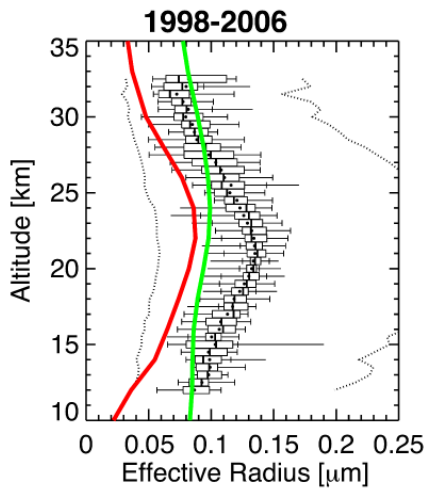
Fig. 13. Vertical profiles of the effective radius derived from OPC measurements in the stratosphere over Laramie (WY; Deshler et al., 2003a) compared to model results. The OPC data, in black, were re- binned according the vertical resolution of the model. Shown is the vertical profile of the data median. The box represents the interquar- tile range, i.e. 0.25 and 0.75 percentiels. Circles mark mean values of the measurements. The spread of the data is shown as whiskers denoting 1 . 5 × IRQ values, and outliers larger than that. Dashed lines represent R eff when the error estimates of the underlying sur- face area and volume density integrals from size distributions fitted to measurements are taken into account, details are given in Desh- ler et al. (2003a). The model effective radius was retrieved for the whole spectrum ( R ≥ 1nm; red) and for the visible range of optical instruments ( R ≥ 50nm;